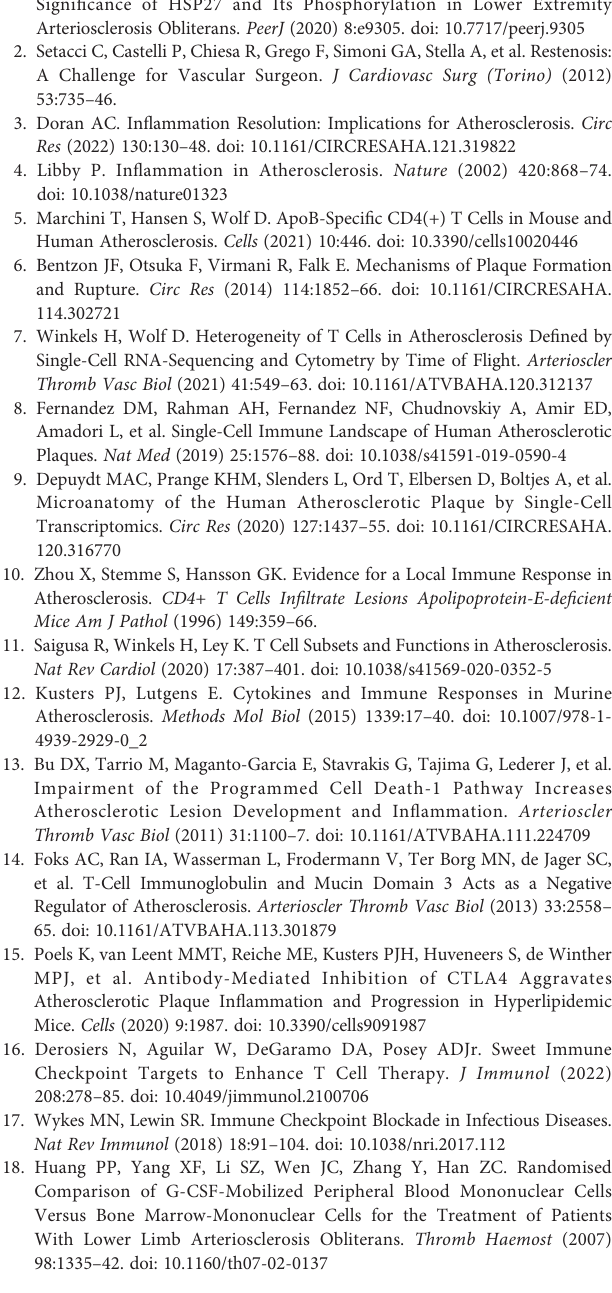
Supplementary Figure 2 | Phenotype of Tim-3 + PD-1 + CD4 + T cells in HCs and LEASO. Quanti fi cation of fl ow cytometric analysis of CD45RO (A) and TGF- b 1 and IL-17A (B) by Tim-3 + PD-1 + CD4 + T cells from HCs and LEASO. Data represent mean ±